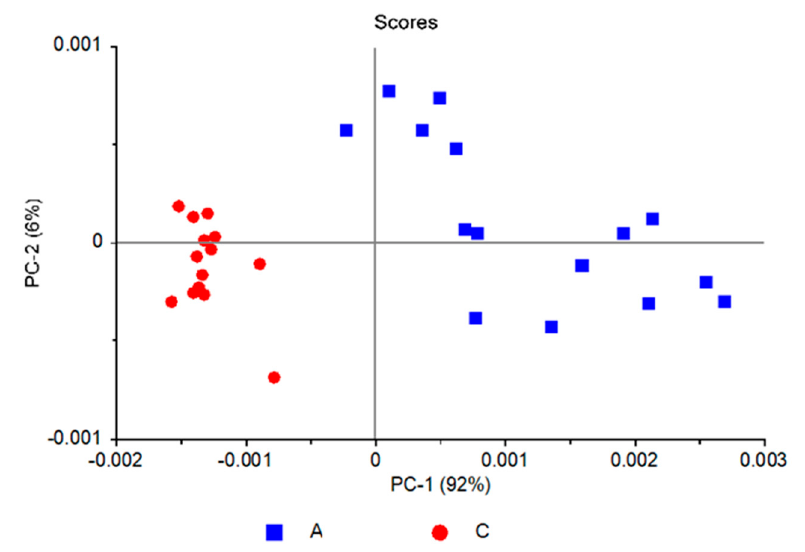
Figure 3. PCA scores plot (PC-2 vs. PC-1) for the PCAModel.